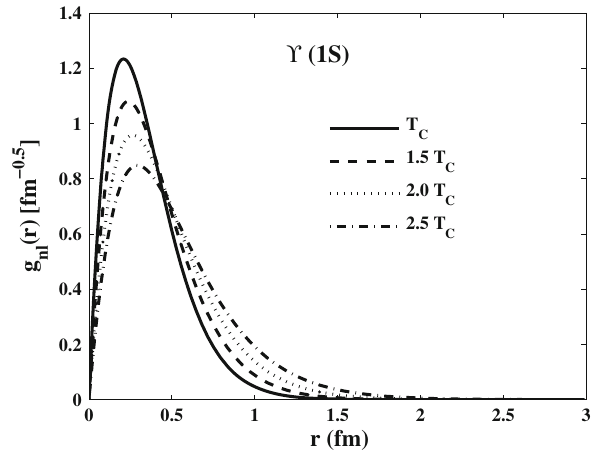
Fig. 7 Variation of radial wavefunction of ϒ( 1 S ) with respect to r at T = T C , 1 . 5 T C , 2 . 0 T C and 2 . 5 T